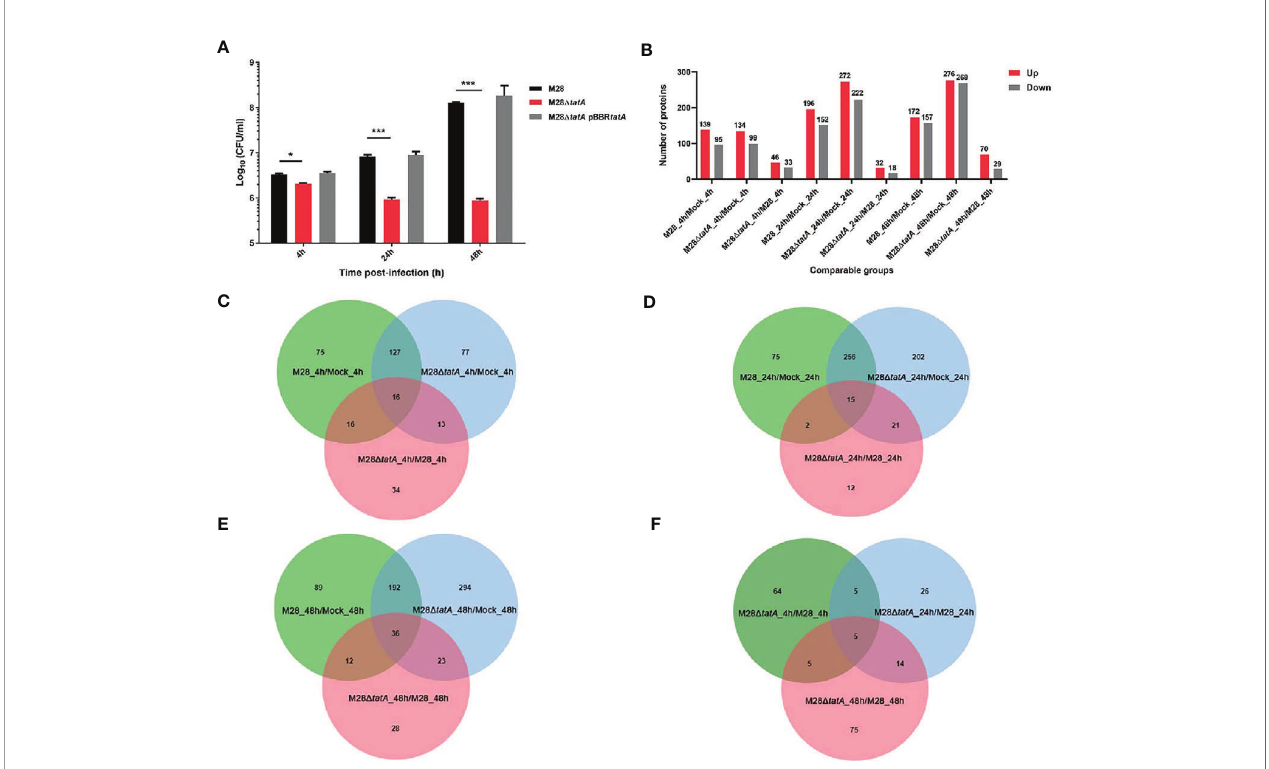
FIGURE 1 | Label-free proteomics of RAW264.7 macrophages infected with M28 and M28 D tatA . (A) Intracellular CFU of M28 and its derivatives in murine RAW264.7 cells. Asterisks denote statistically signi fi cant differences between the M28 D tatA mutant group and the parental strain M28 group based on the Student ’ s t test (*p < 0.05; ***p < 0.001). All tests were done 3 times. (B) The number of DEPs in the different comparison groups. (C) Venn diagrams displaying the overlap of DEPs at 4 hpi. (D) Venn diagrams displaying the overlap of DEPs 24 hpi. (E) Venn diagrams displaying the overlap of DEPs 48 hpi. (F) For the M28 D tatA /M28 group, Venn diagrams displaying the overlap of DEPs at 4, 24 and 48